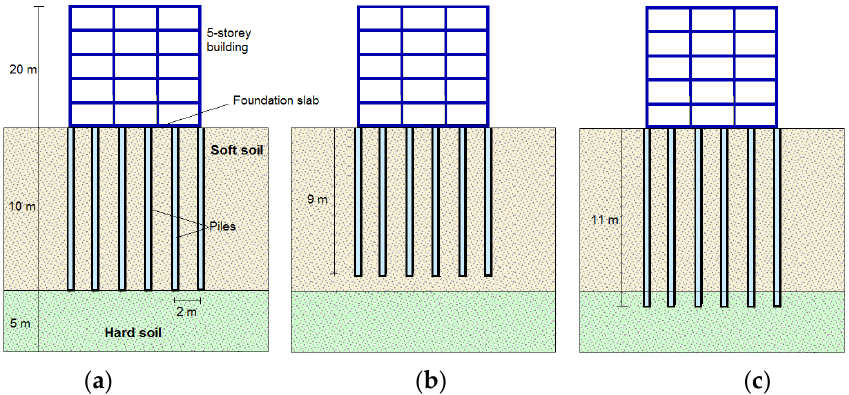
Figure 7. Soil–rigid inclusions–structure systems analyzed with different support conditions. ( a ) P-RI; ( b ) F-RI; ( c ) A-RI.